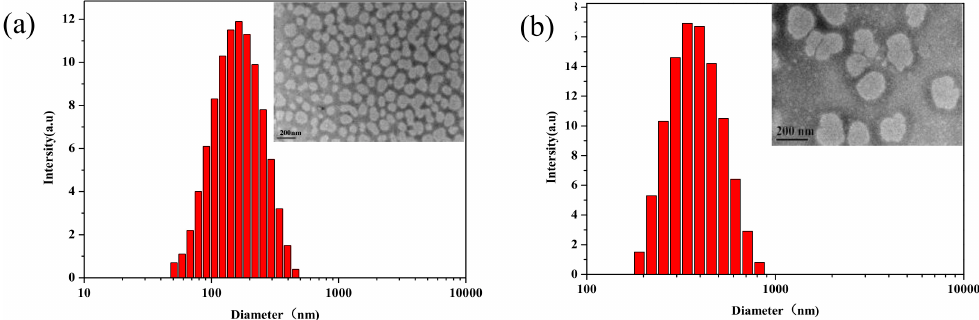
Figure 5. TEM images and size distribution profiles of tBP3 micelles in distilled water, determined by DLS measurement at 25 °C ( a ) and 35 °C ( b ) (2 mg·mL − 1 ).